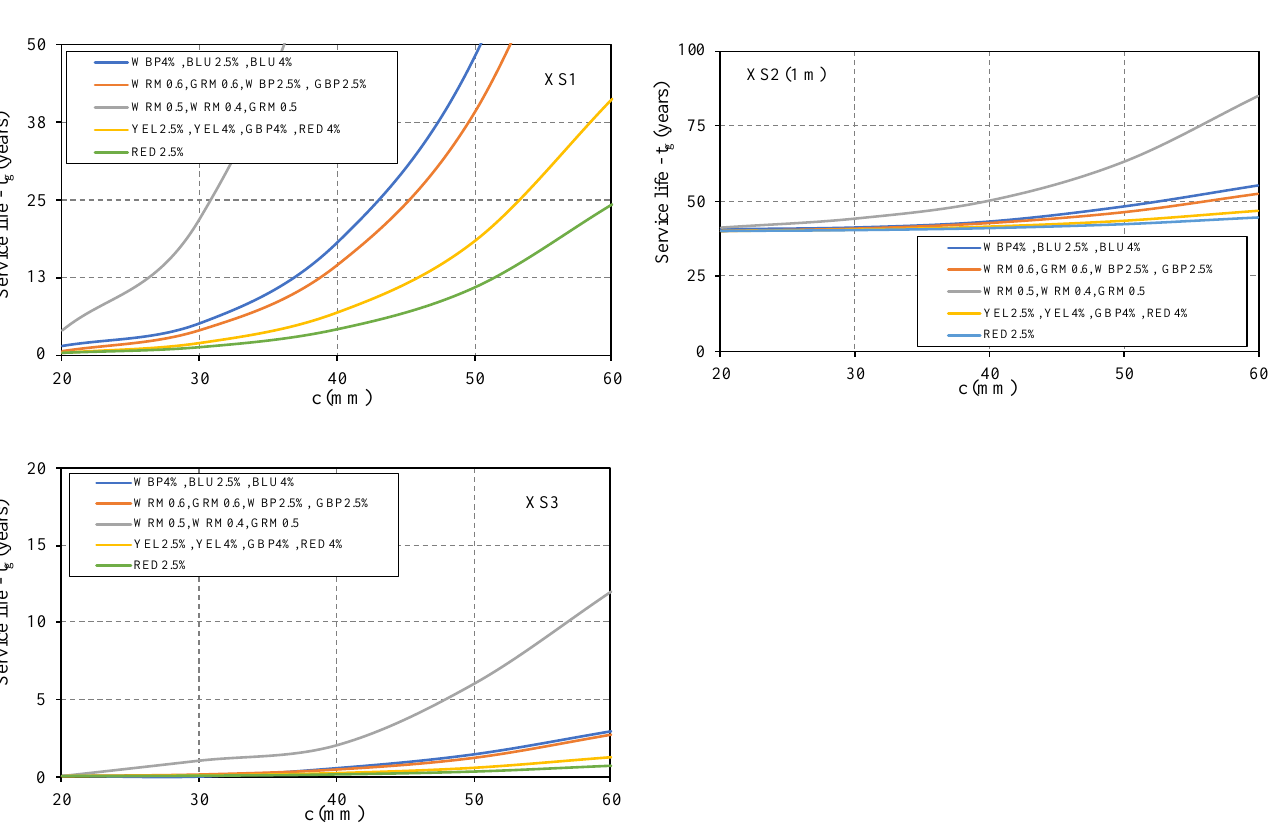
Figure 11. Prediction of the service life for current structures, classes XS.